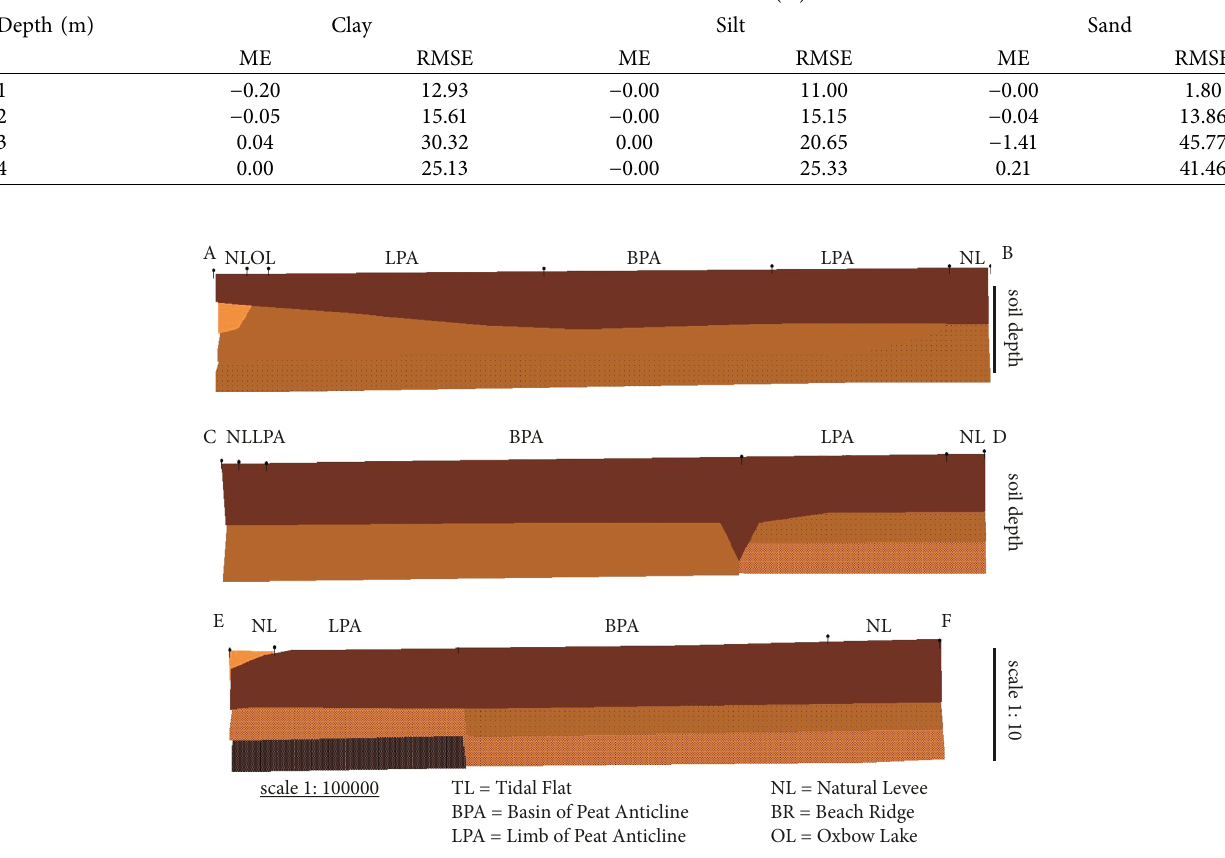
Table 2: Cross-validation of ME and RMSE of soil fraction mapping in each soil depth applying Bayesian statistics. Depth (m)